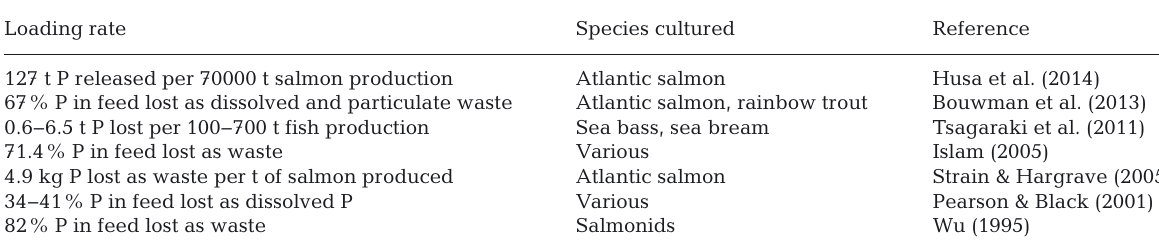
Table 3. Phosphorus (P) loading at ocean fish aquaculture sites. Values are presented in the units of the original